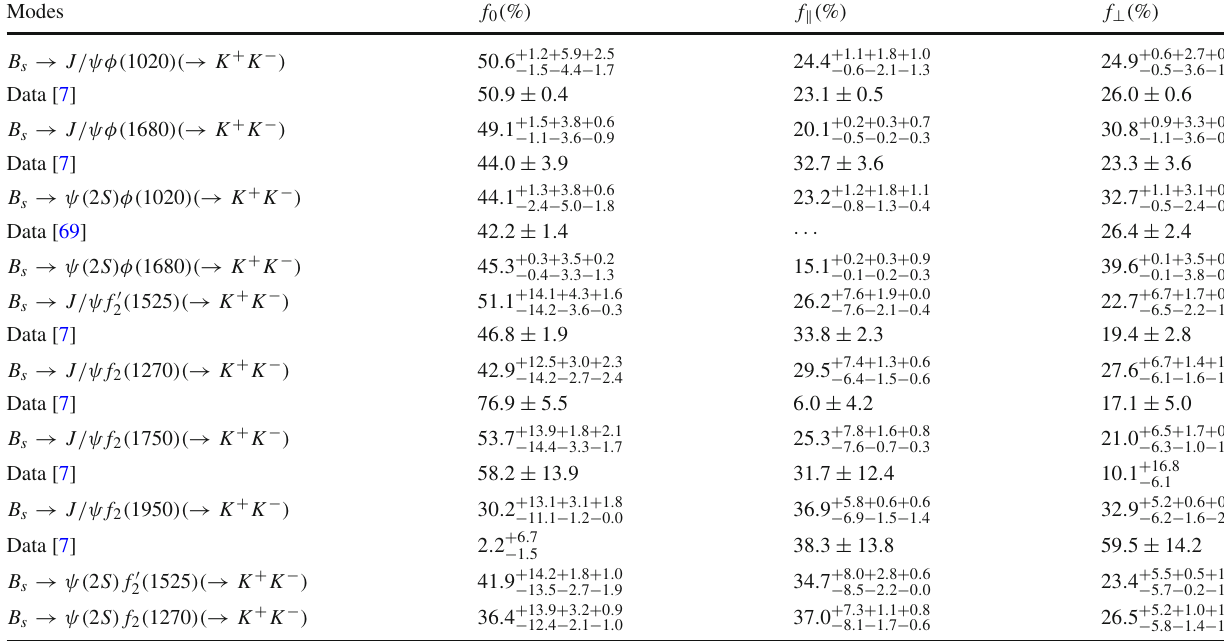
Table 5 Polarization fractions for the decays B s → ( J /ψ,ψ( 2 S ))φ/ f 2 ( → K + K − ) . For theoretical errors, see Table 3. The experimental data are taken from Ref. [7], where the statistical and systematic uncertainties are combined in quadrature Modes f 0 ( %